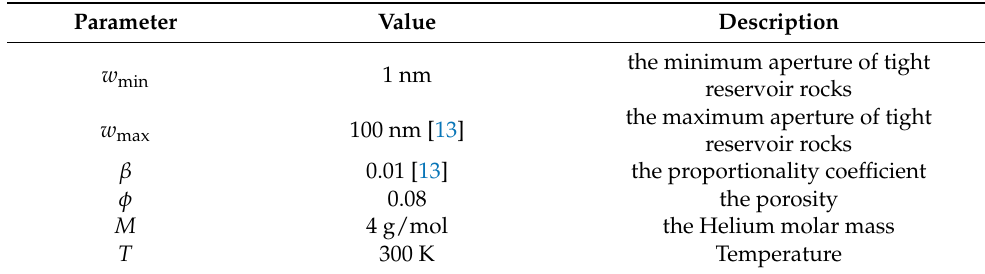
Table 2. Model structural parameters and gas properties.